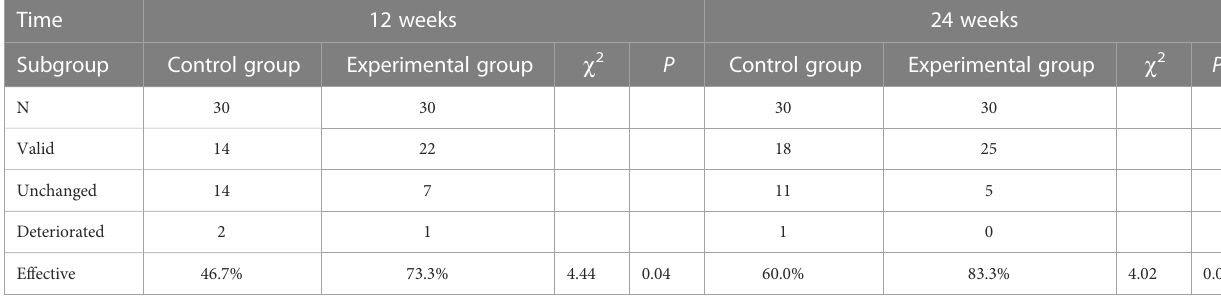
TABLE 2 Comparison of effective rates between the two groups.